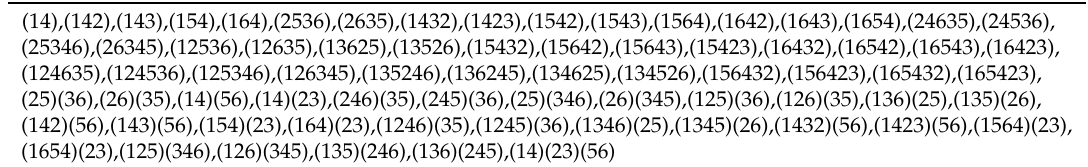
Table 1. Seventy-two permutations that are not in p ( C ) by Proposition